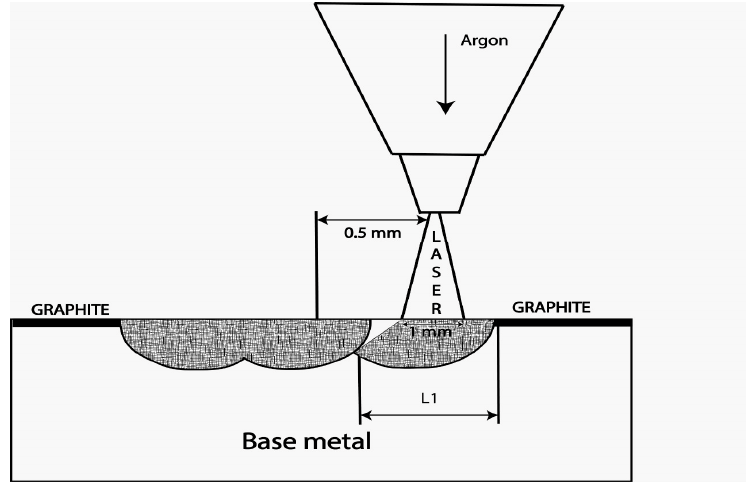
Figure 6. Experimental setup of the LSM treatments [94] . Table 6. LSM treatment on biomedical alloys.